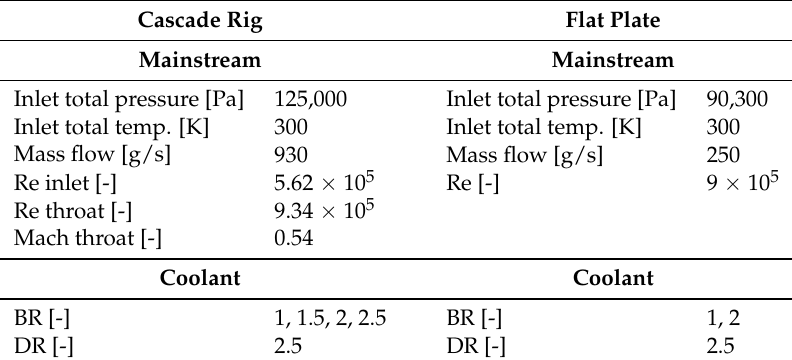
Table 1. Film cooling parameters estimated at nominal